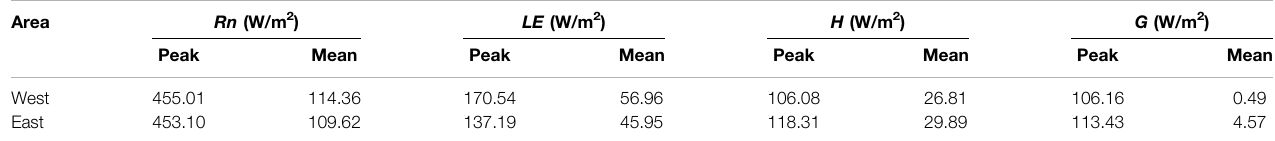
TABLE 4 | Annual average daily peak values and average daily values of the energy components. R n is the net radiation, LE is the latent heat fl ux, H is the sensible heat fl ux, and G is the soil heat fl